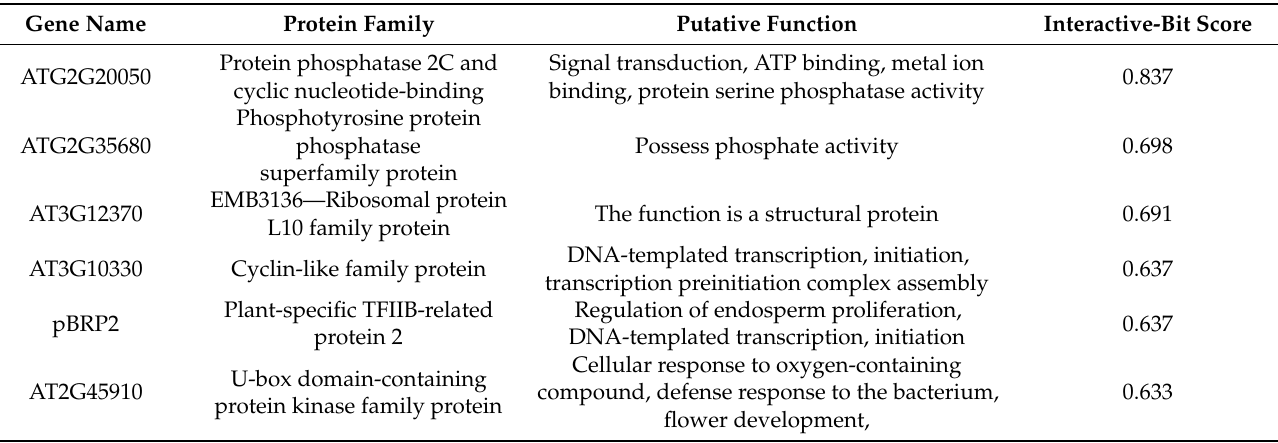
Figure 4. The predicted functional partners of TaTLP protein. Table 2. Different predicted protein families interacted with TaTLP